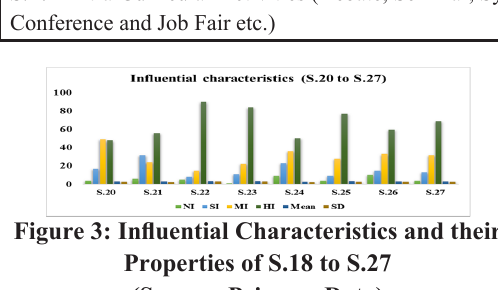
Figure 3: Influential Characteristics and their Properties of S.18 to S.27